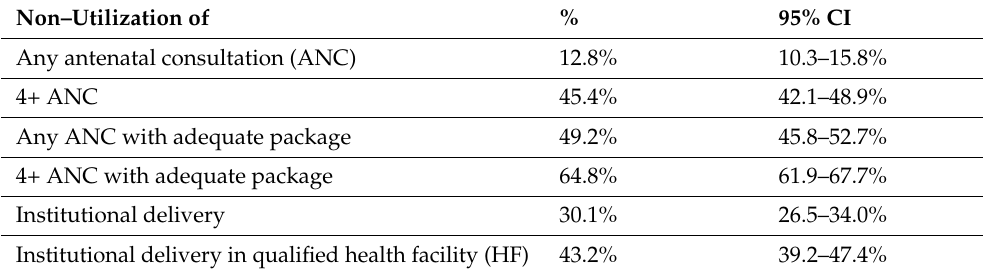
Table A2. Maternal health care cascade non-utilization indicators, Mozambique health survey,